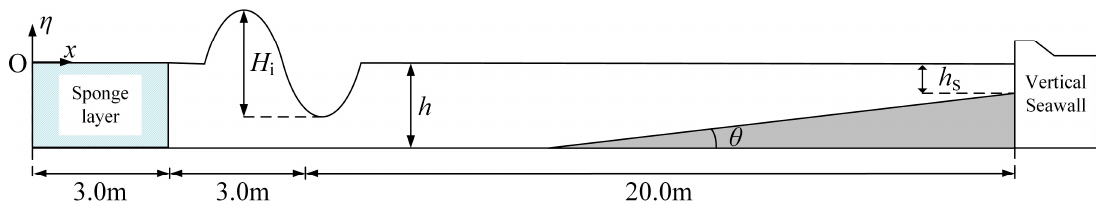
Figure 9. Numerical experiment setup. Table 3. Numerical experimental wave conditions.